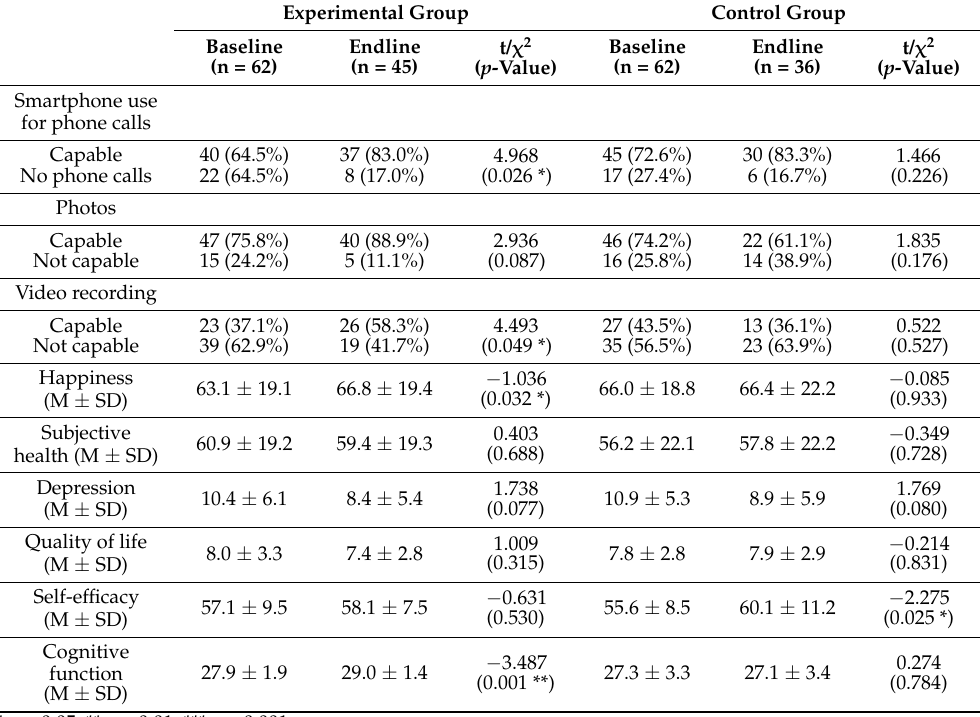
Table 3. Comparison of pre- and post-digital literacy education changes.